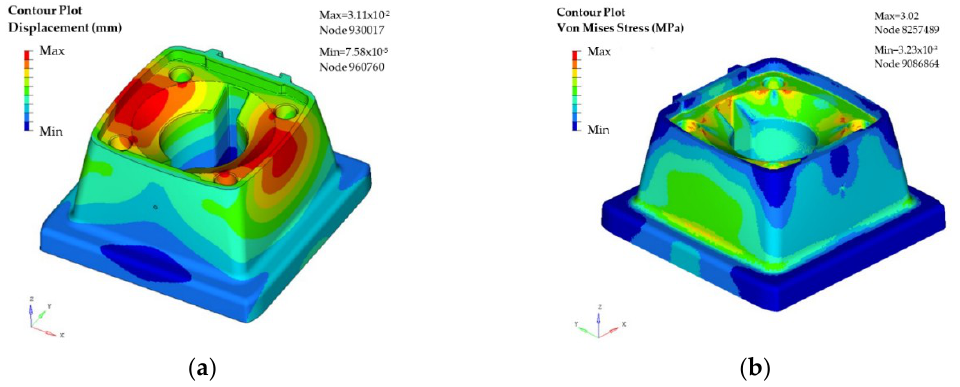
Figure 10. Case study part (support): ( a ) Displacements of the material for the solid model; and ( b ) Von Mises stress for the solid model.